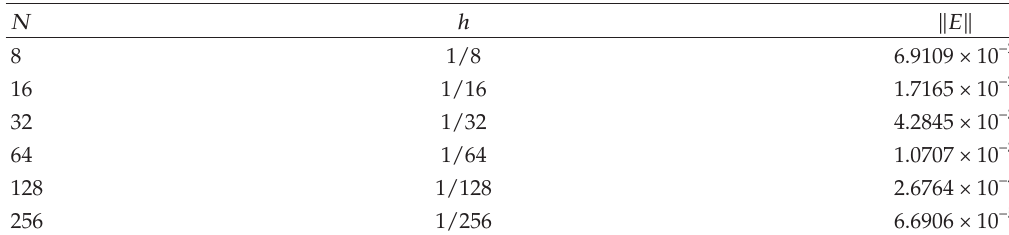
Table 1: Results for Example 4.1.